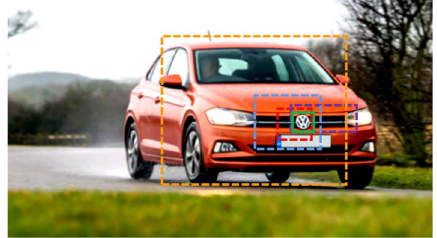
Fig. 1 Diversity of bounding box regression, where green box is the ground-truth